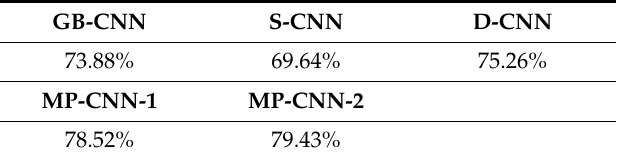
Table 3. Classification accuracy of the WHARF dataset using different methods.